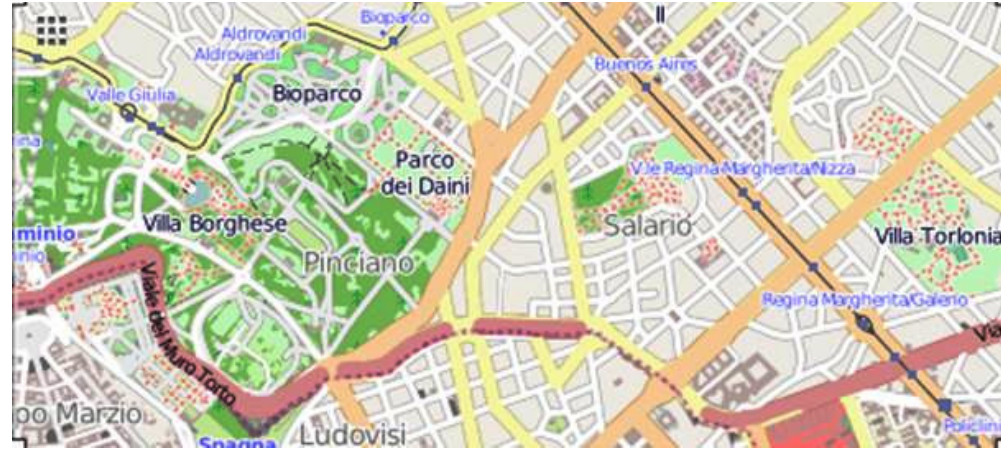
Figure 6. Map of the city center of Rome as from